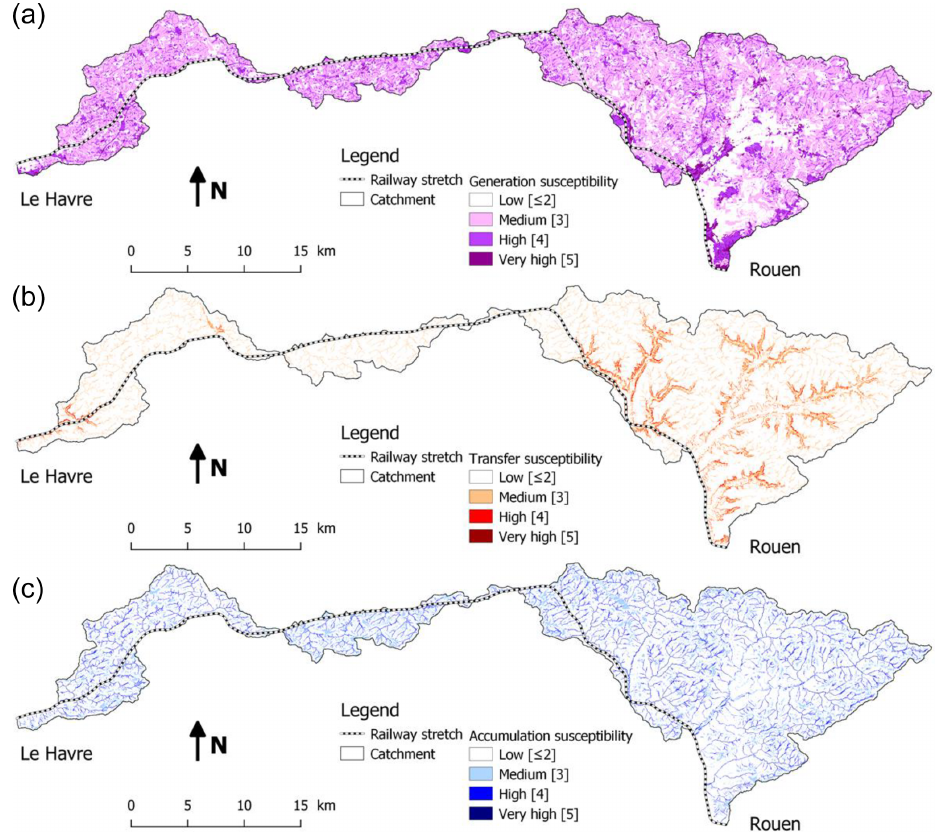
Figure 6. IRIP susceptibility maps to runoff generation (a) , transfer (b) and accumulation (c) .